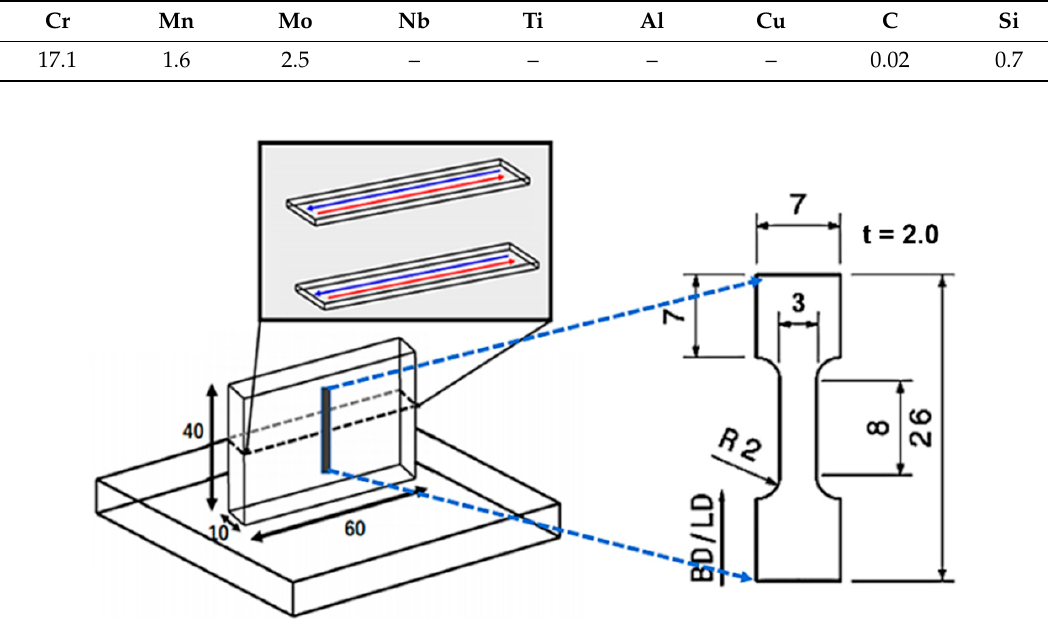
Figure 1. Schematic giving detailed information on the building direction and scanning strategy in the DED process and the dimensions of the specimens (dimensions in mm) cut for SMAT processing. Table 1. Chemical composition of the SS 316L powder used in the present work (wt.%).